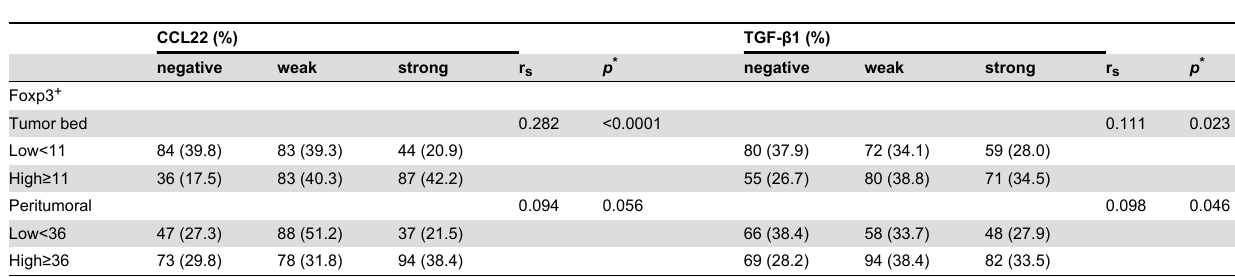
Table 4. Correlation of CCL22 or TGF-β1 and Foxp3 + Tregs